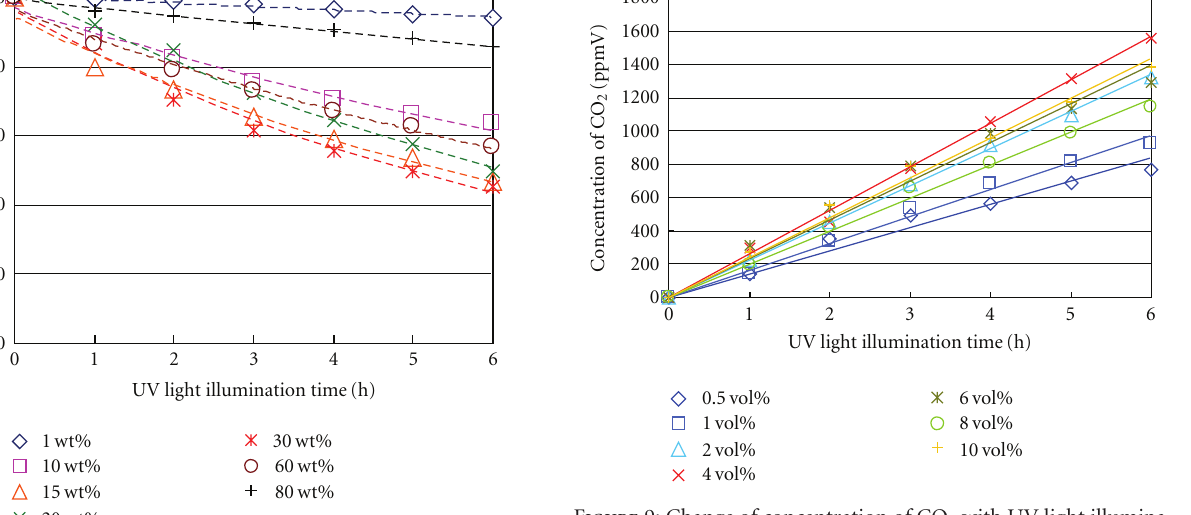
Figure 9: Change of concentration of CO 2 with UV light illumina- tion time for di ff erent initial concentrations of O 2